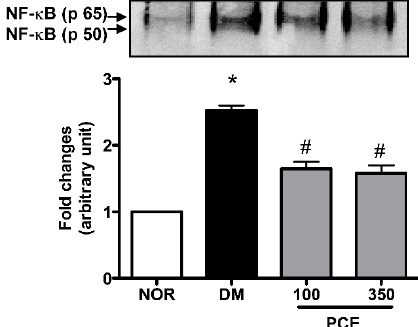
Figure 4. The effect of PCE on NF ‐κ B activation in the retina. The DNA ‐ binding activity of NF ‐κ B was measured using EMSA. Representative protein expression in a normal rat (NOR), an STZ ‐ induced diabetic rat (DM), a DM treated with 100 mg/kg PCE (PCE ‐ 100), and a DM treated with 350 mg/kg PCE (PCE ‐ 350). All data are expressed as the mean ± SEM ( n = 8). * p < 0.01 vs. the NOR group and # p < 0.01 vs. the DM group.